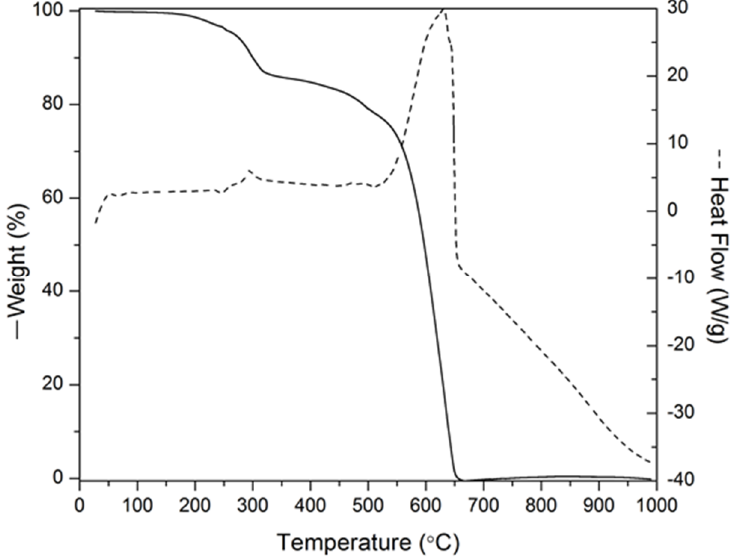
Figure 1. TGA (solid line) and DSC (dotted line) thermograms of the [5]helicenebenzoquinone (exotherm up).